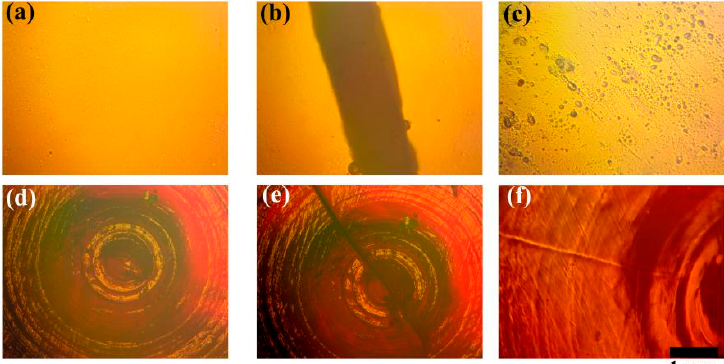
Figure 8. Microscope images of as-prepared ( a ) carrageenan gels and ( d ) PDN gels, cut ( b ) carrageenan gels and ( e ) PDN gels, and healed ( c ) carrageenan and ( f ) PDN gels.